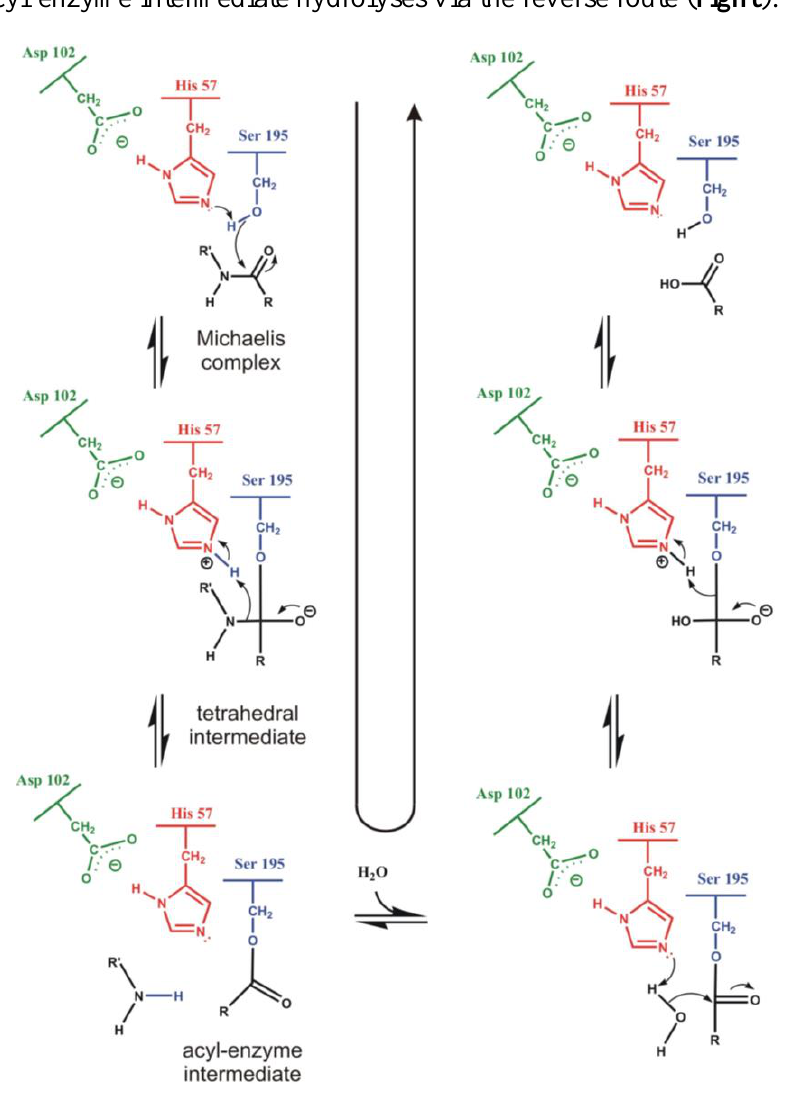
Figure 2. Reaction steps during serine protease catalyzed cleavage of the peptide bond ( left ). The acyl-enzyme intermediate hydrolyses via the reverse route ( right